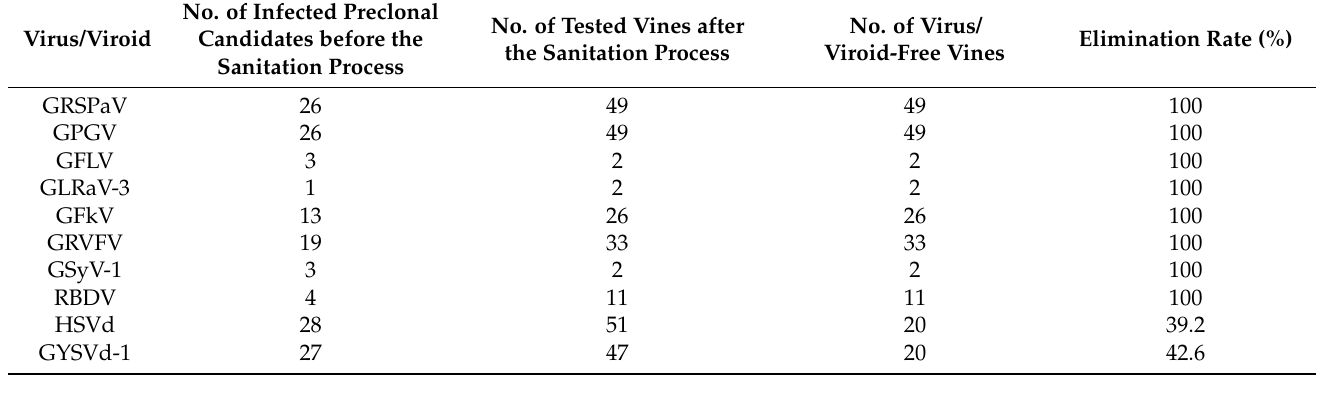
Table 2. Number of infected preclonal candidates before the sanitation process, number of tested vines after the sanitation process, number of virus/viroid-free vines, and elimination rate (%) per individual virus/viroid.